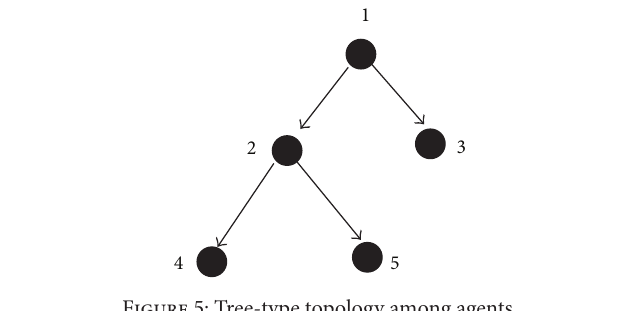
Figure 5: Tree-type topology among agents.